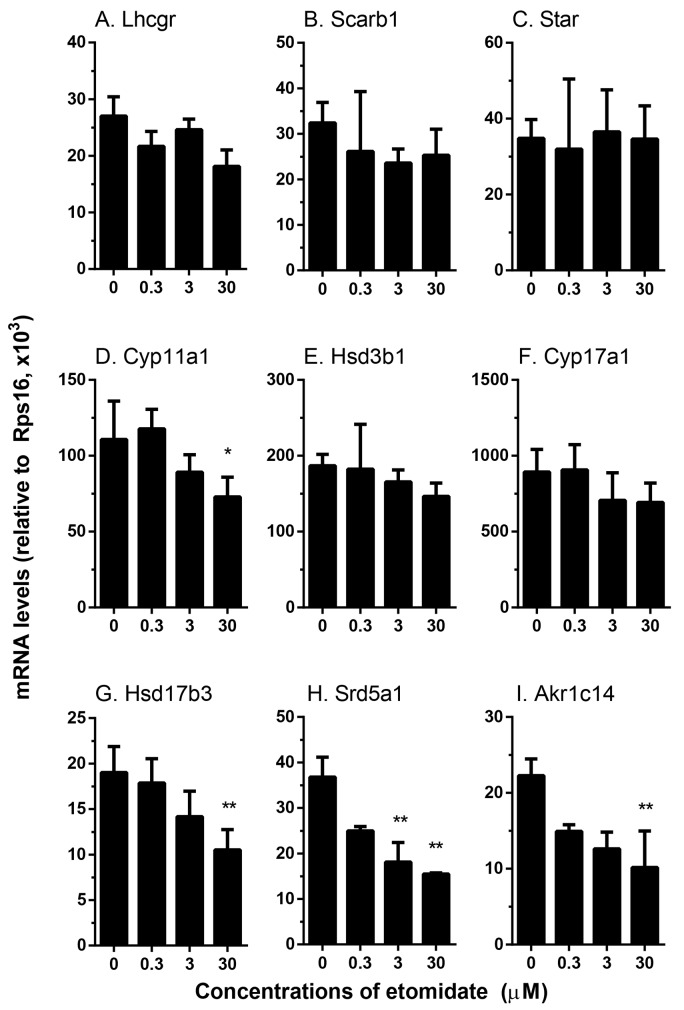
Effects of etomidate on the expression levels of steroidogenesis related genes in rat immature Leydig cells.Rat immature Leydig cells were cultured with 0.3–30 μM etomidate (ETO) for 3 hrs. The expression levels of steroidogenesis-related genes were measured and calculated relatively to Rps16, the internal control. Mean ± SEM, n = 4; *, **, *** indicate significant difference when compared to control at P < 0.05, 0.01, 0.001, respectively.